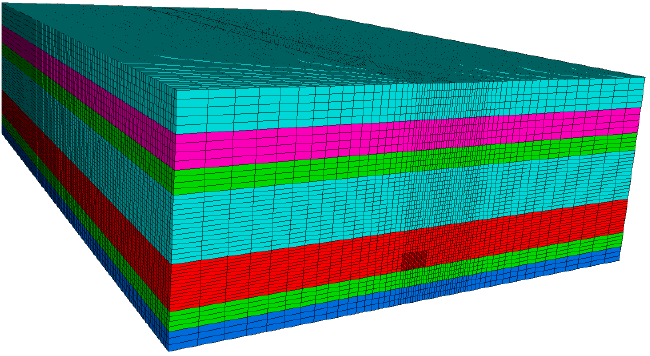
Figure 3. The numerical model.